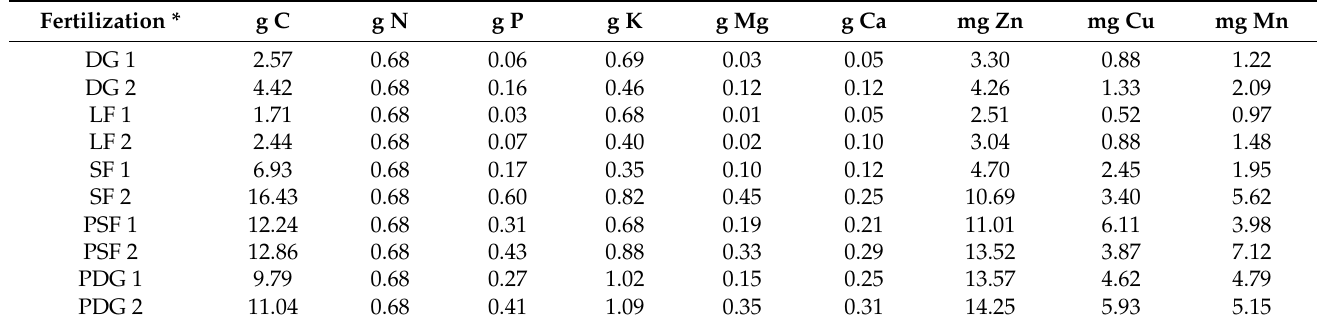
Table 1. Doses of macronutrients (g pot − 1 ) and heavy metals (mg pot − 1 ) used in the experiment (C = carbon, N = Nitrogen, P = Phosphorus, K = Potassium, Mg = Magnesium, Ca = Calcium, Zn = Zinc, Cu = Copper, Mn =